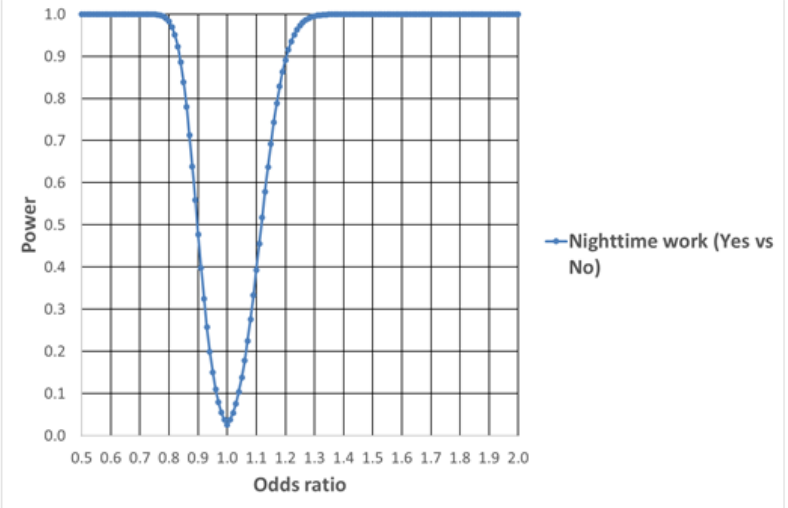
Figure 6. Power to detect an effect of night shift work on the odds of redeemed prescriptions for antidepressants vs anxiolytics, as a function of underlying odds ratios ( α